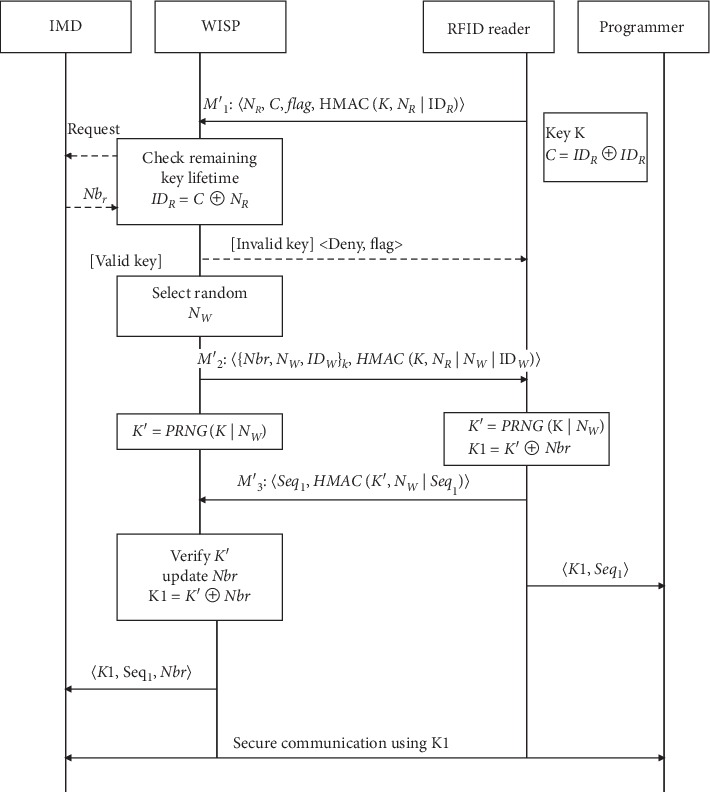
Secure communication protocol between the IMD and the programmer (protocol 5) (Algorithm 3).